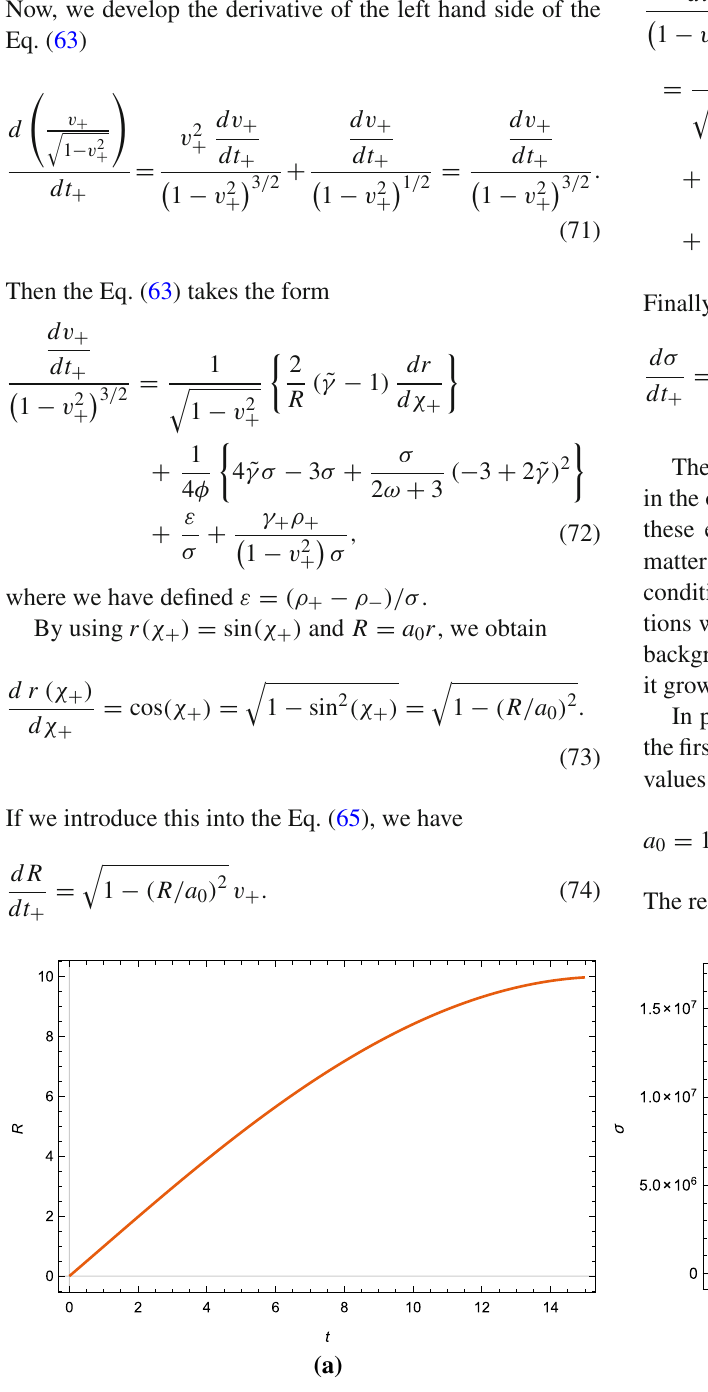
Fig. 5 Evolution of the true vacuum bubble for γ f = 0 . 7. a Radius of the bubble as a function of time t + . b Surface energy density as a function of time t